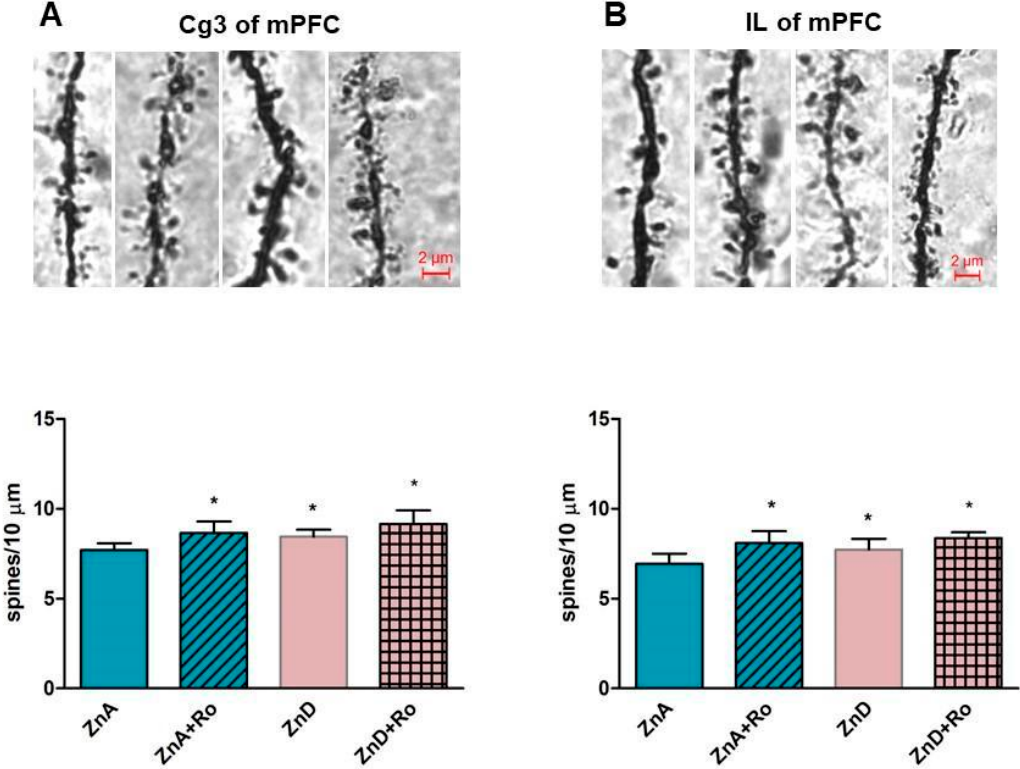
Figure 4. The e ff ect of a single dose of Ro 25-6981 on density of dendritic spines in the Cg3 cortex ( A ) Figure 4. The effect of a single dose of Ro 25 ‐ 6981 on density of dendritic spines in the Cg3 cortex ( A ) and IL cortex ( B ). Ro 25-6981 (10 mg / kg; i.p. ) was administered 180 min before the decapitation, n = and IL cortex ( B ). Ro 25 ‐ 6981 (10 mg/kg; i.p. ) was administered 180 min before the decapitation, n =